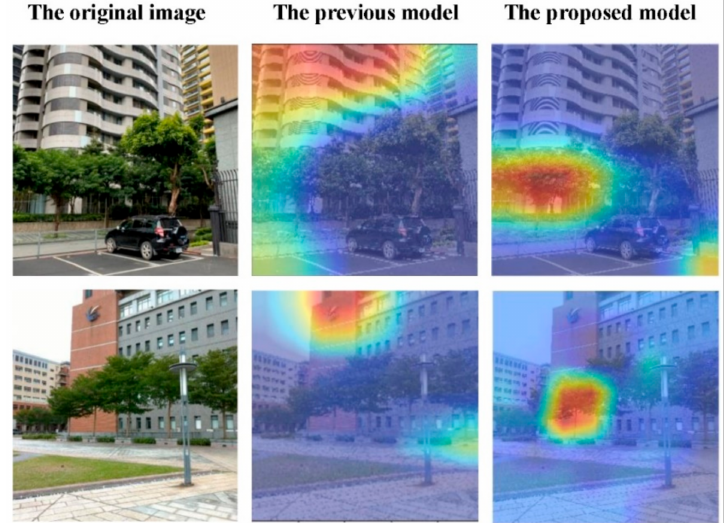
Figure 9. Grad-CAM visualizations of the proposed model. The left column is the original images in our tree species dataset. The middle column is the Grad-CAM visualizations of our previous trained model. The right column is the Grad-CAM results of our proposed model. The heat maps localize class-discriminative regions, and red regions correspond to high score for